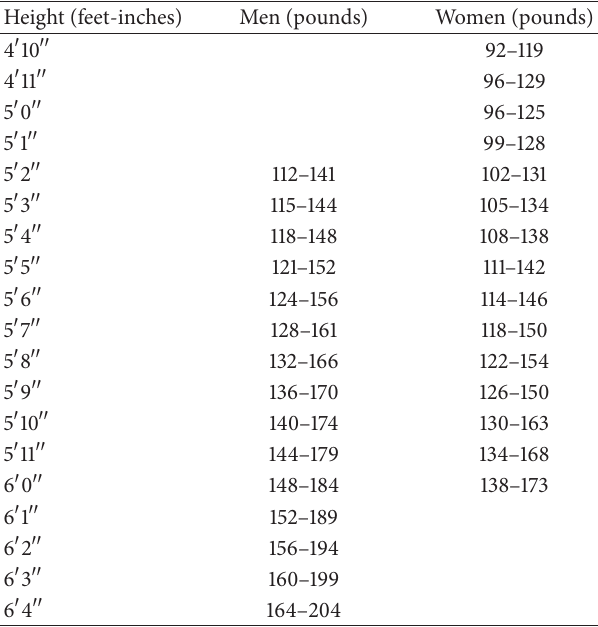
Table 2: Range of acceptable body weight